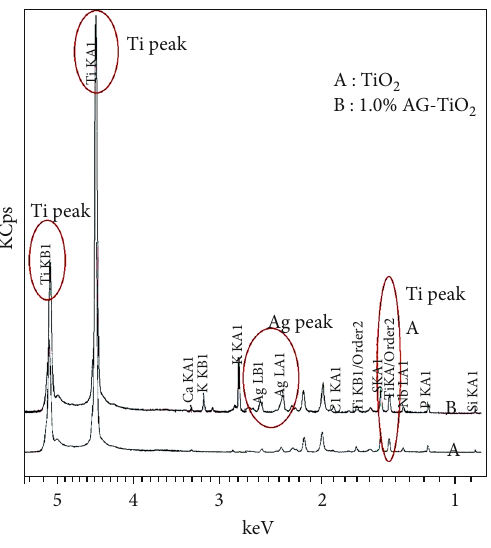
Figure 3: The XRF patterns of TiO